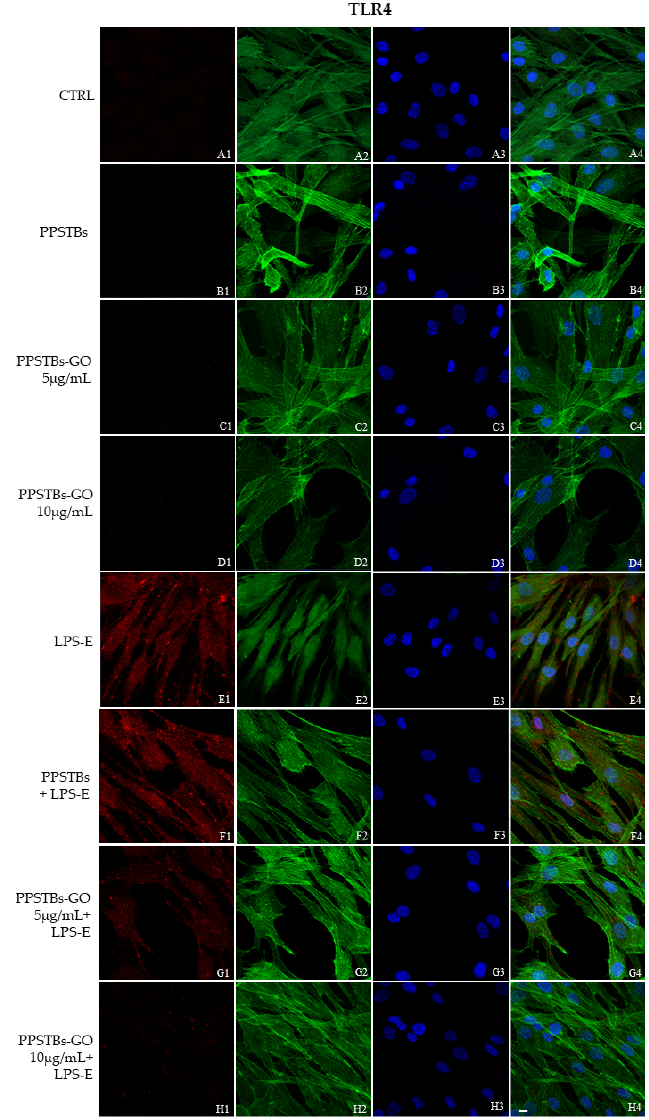
Figure 5. TLR4 signaling pathway in hGFs cell line. Expression of TLR4 analyzed by confocal microscopy ( A1 – H4 ), TLR4 expression in untreated cells (CTRL), in hGFs cultured with PPSTBs, in hGFs cultured with PPSTBs enriched with GO at 5 μ g/mL, in hGFs cultured with PPSTBs enriched with GO at 10 μ g/mL, in hGFs stimulated with LPS ‐ E, in hGFs cultured with PPSTBs and stimulated with LPS ‐ E, in hGFs cultured with PPSTBs enriched with GO at 5 μ g/mL and stimulated with LPS ‐ E and in hGFs cultured with PPSTBs enriched with GO at 10 μ g/mL and stimulated with LPS ‐ E. Red fluorescence: TLR4 ( A1 – H1 ); Green fluorescence: cytoskeleton actin ( A2 – H2 ); Blue fluorescence: cell nuclei ( A3 – H3 ) and Merge ( A4 – H4 ). Scale bar: 20 μ m.